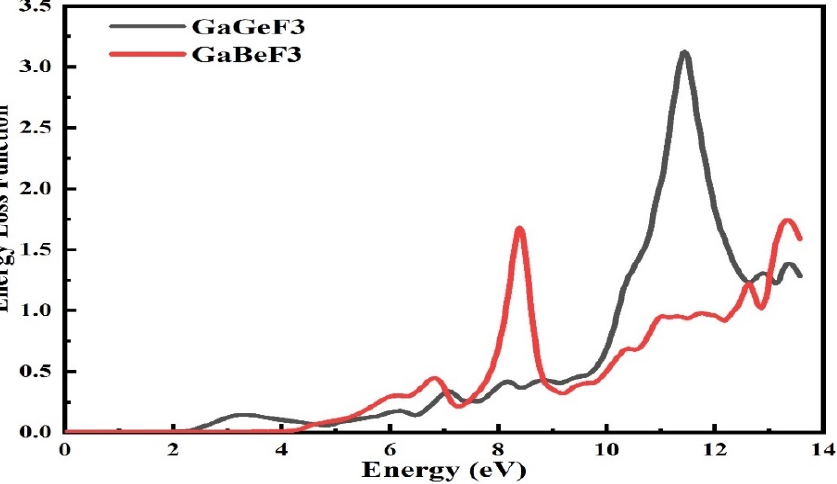
Figure 10. The computed optical energy loss function L( ω ) of the GaMF 3 (M = Ge and Be) compound.